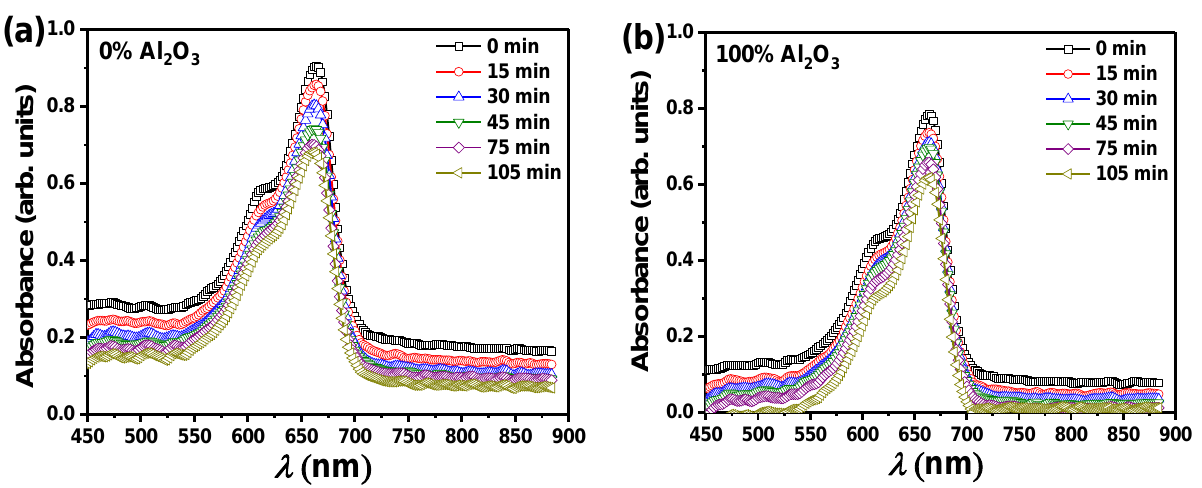
Figure 6. UV-visible absorption spectra of MB as a function of λ after photoreduction of the MB for various times using ( a ) pure PbO, and ( b ) pure Al 2 O 3 nanoparticles as catalysts. 𝐶 𝑡 Figure 7a illustrates the MB dye photodegradation rate ( ) versus the irradiation 𝐶 𝑜 time ( t ) for PbO- x %Al 2 O 3 composites. It is obvious from the figure that the PbO-40%Al 2 O 3 composites showed a faster degradation rate of the MB and was reached a constant value after 20 min of the UV-visible irradiation. On another side, the PbO-10%Al 2 O 3 composites revealed the highest value of photocatalytic activity compared to other composites. On the other hand, pure Al 2 O 3 (100% Al 2 O 3 ) nanoparticles had a lower photocatalytic activity value, which could be related to the greater bandgap limiting the visible absorption re- gion. The increased photogenerated electrons and holes, which might be separated in the case of PbO nanoparticles, are the principal light absorbers for composites with a larger ratio of PbO. As a result, we may conclude that the PbO nanoparticle is a good photoelec- tron acceptor, trapping the photoelectron and reducing photoelectron-hole pair recombi- nation when compared to Al 2 O 3 . Additional tests were performed to confirm such con- cerns, and the results are shown later.